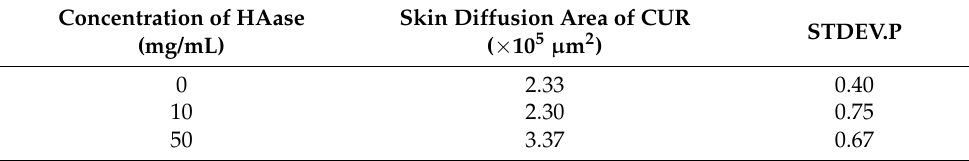
Figure 5. ( a ) Skin diffusion images of CUR-NCs (bar: 100 µm), ( b ) skin diffusion area and ( c ) fluorescence intensity of the CUR-MNs containing different HAase concentrations. (Significance is denoted in the figure as * p < 0.05, and ** p < 0.01). Table 3. The skin diffusion area of the CUR-MNs containing different HAase concentrations.